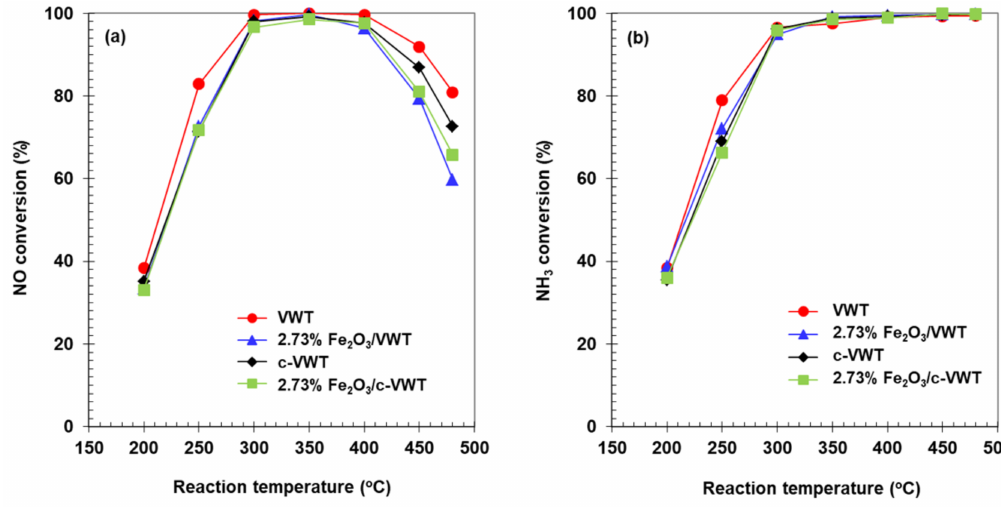
Figure 3. Conversions of ( a ) NO and ( b ) NH 3 in the reduction of NO by NH 3 over unpromoted and Fe 2 O 3 -promoted V 2 O 5 /TiO 2 -based